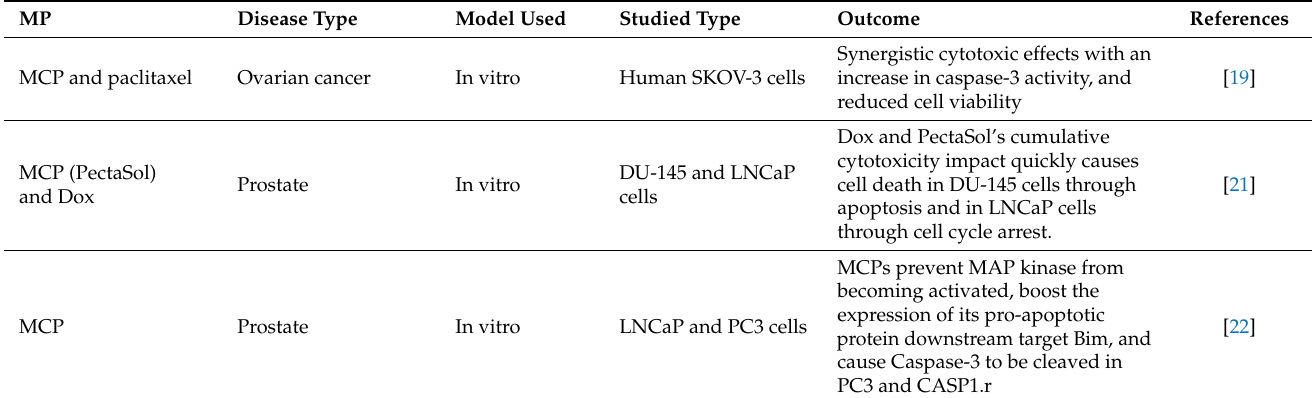
Table 4. Synergistic health benefits of modified